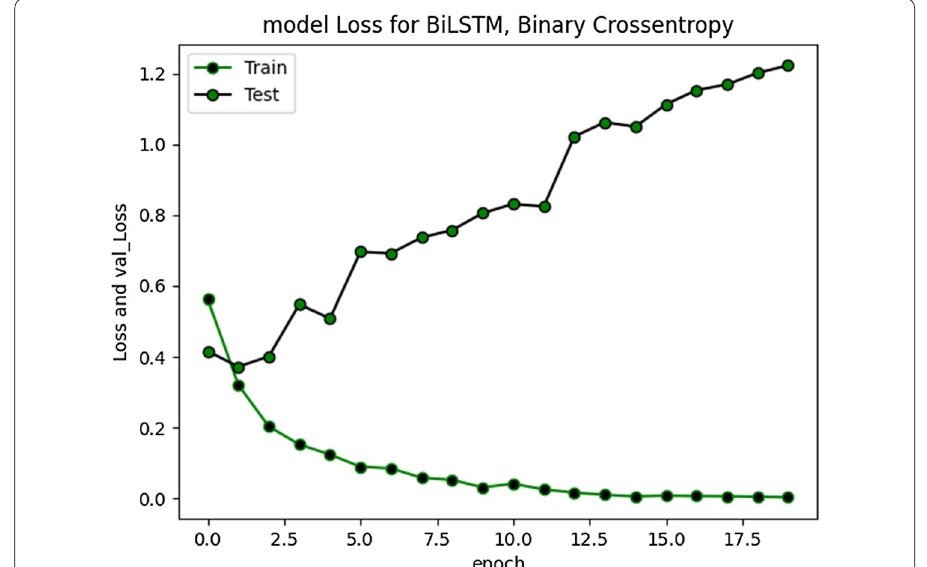
Fig. 12 RNN-BiLSTM Model loss plot- Binary Cross entropy for 20 epochs